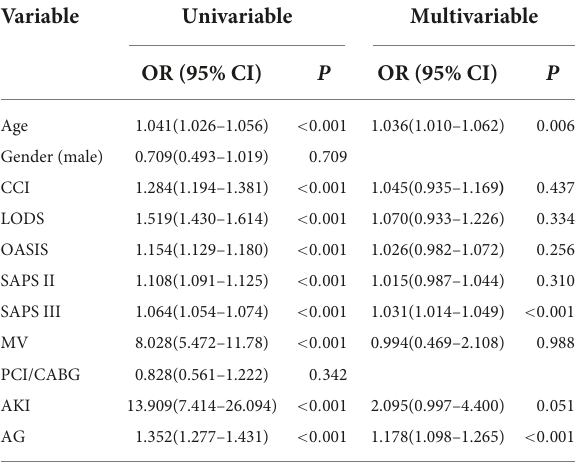
TABLE 2 Binomial logistic regression analysis for in-hospital mortality among coronary care unit patients with AMI (before PSM).